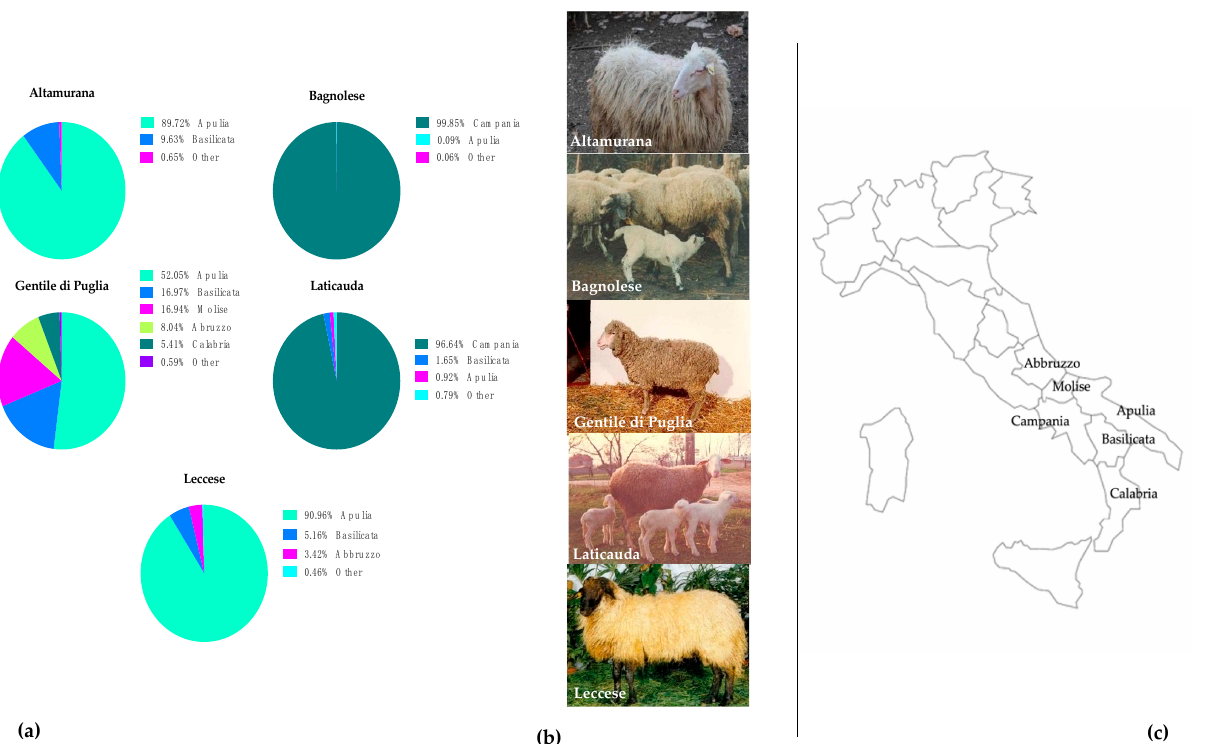
Figure 1. ( a ) Parts of whole representation in percentage of the five sheep breed most represented in Southern Italy; Altamurana, Bagnolese, Gentile di Puglia, Laticauda and Leccese according to the last census (30 June 2021) from the National Data Bank of the Zootechnical Registry (BDN); ( b ) pictures of Altamurana, Bagnolese, Gentile di Puglia, Laticauda and Leccese by https://www.agraria.org/ovini (accessed on 15 October 2021) ( c ) Southern Italy regions’ maps mainly representative of the autochthonous sheep breeds.